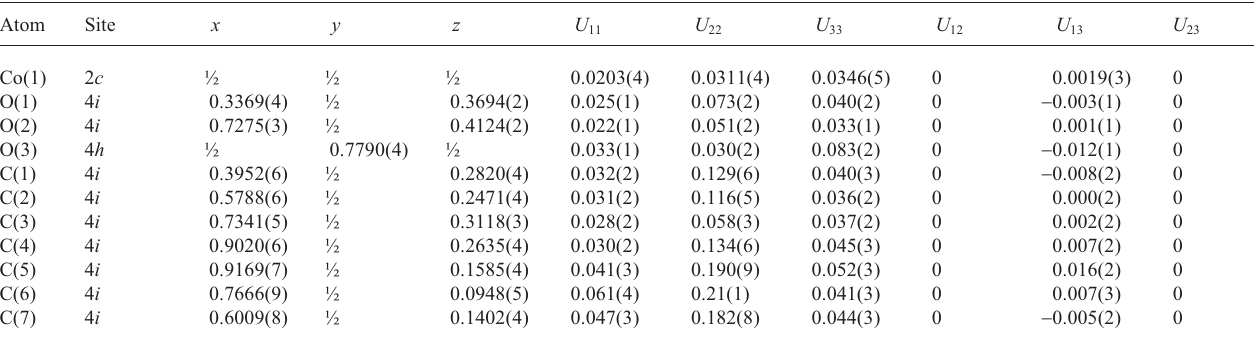
Table 3. Atomic coordinates and displacement parameters (in Å 2 )